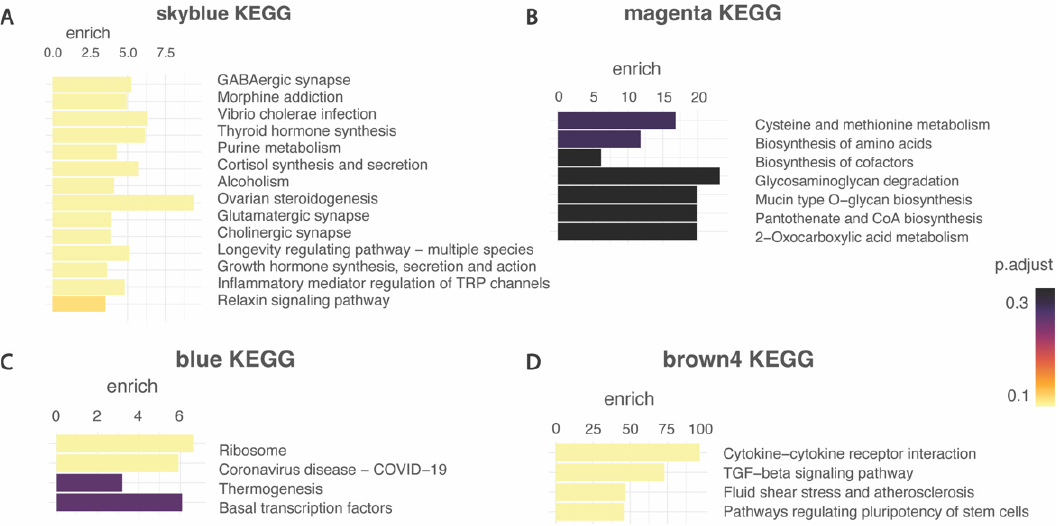
Figure 5. Enrichment analysis in interesting modules. ( A ) Skyblue module, ( B ) magenta module, ( C ) blue modules ( D ) brown4 module. Results include level of significance of each pathway enrich- ment using The Kyoto Encyclopedia for Genes and Genomes (KEGG) calculated and expressed in adjusted p -value, yellow represents more significant and purple least significant.